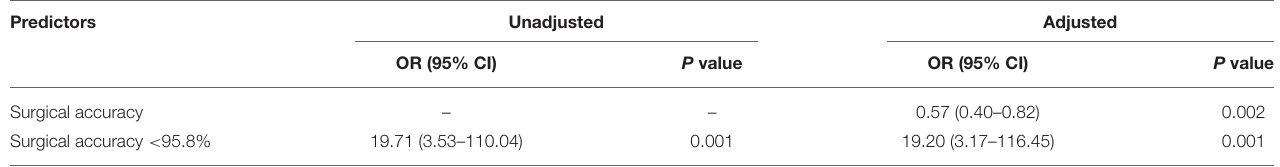
TABLE 6 | Multivariate analysis for predictors of overall postoperative complications.